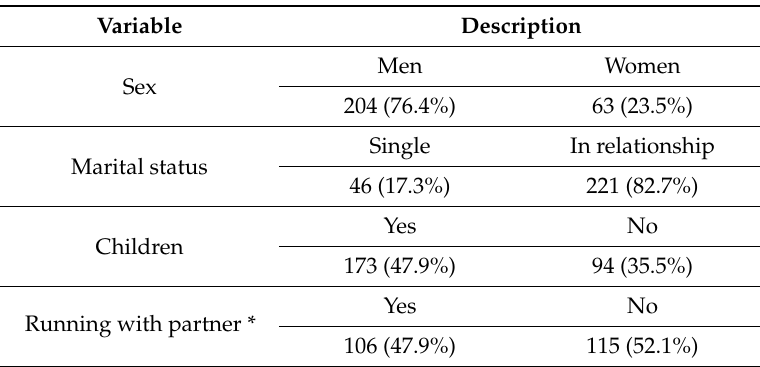
Table 1. Detailed description of ultramarathon runners ( n =